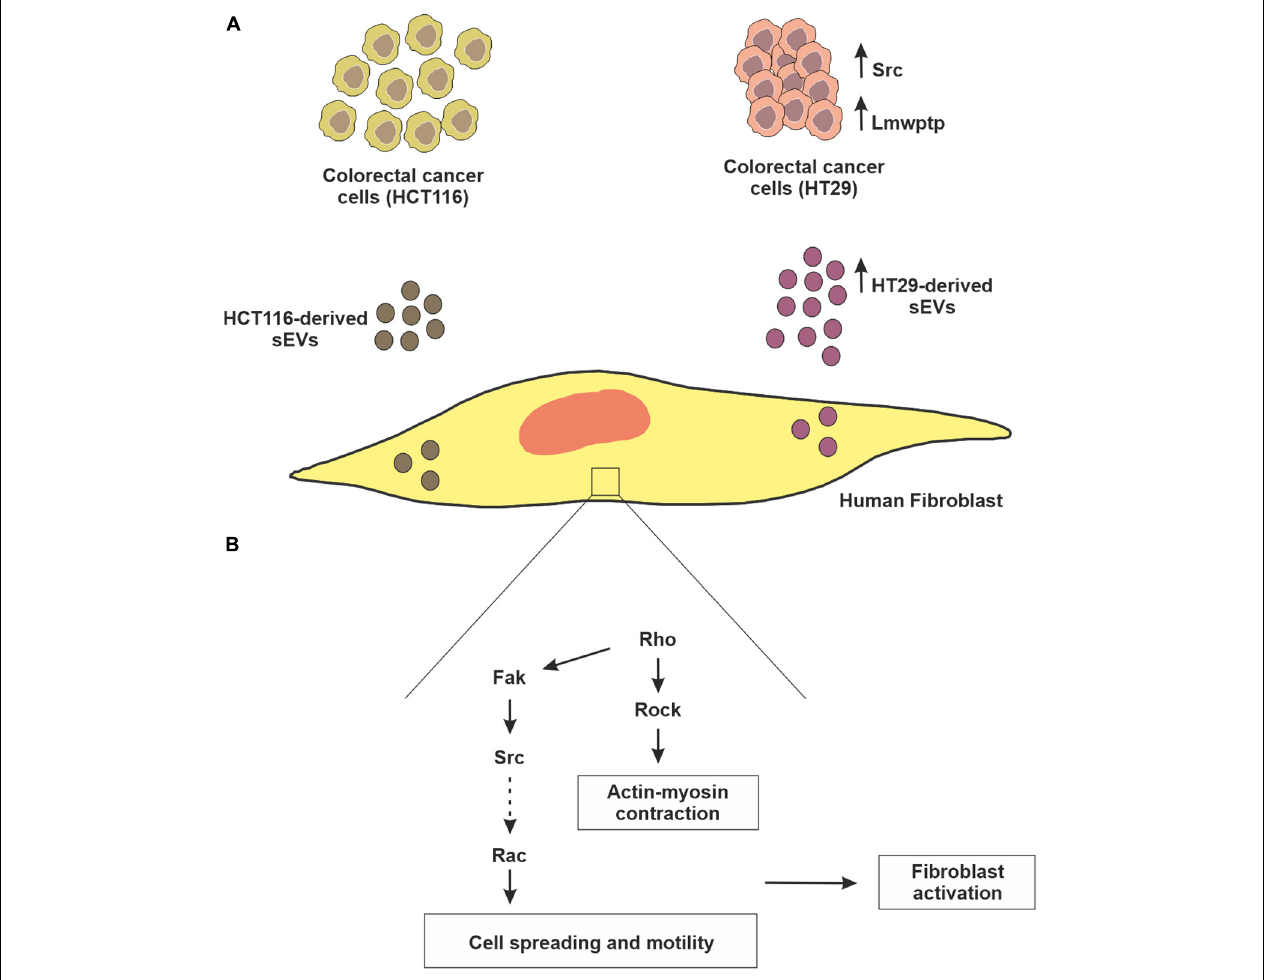
FIGURE 7 | | Schematic representation of fibroblast reprogramming (education) by CRC cell-derived sEVs. (A) Although both colorectal cancer cell lines (HCT116 and HT29) release sEVs, HT29 produces these vesicles in greater concentration, which can be explained, at least in part, due to higher amounts of mediators of biogenesis pathway, as well as Src kinase. Interestingly, HT29 not only has a higher amount of Lmwptp, but this protein is part of the sEVs cargo. (B) In relation to the biological relevance of these sEVs, in the present study, it was observed that they can educate normal fibroblasts, stimulating them to proliferate, migrate and acquire the characteristic of